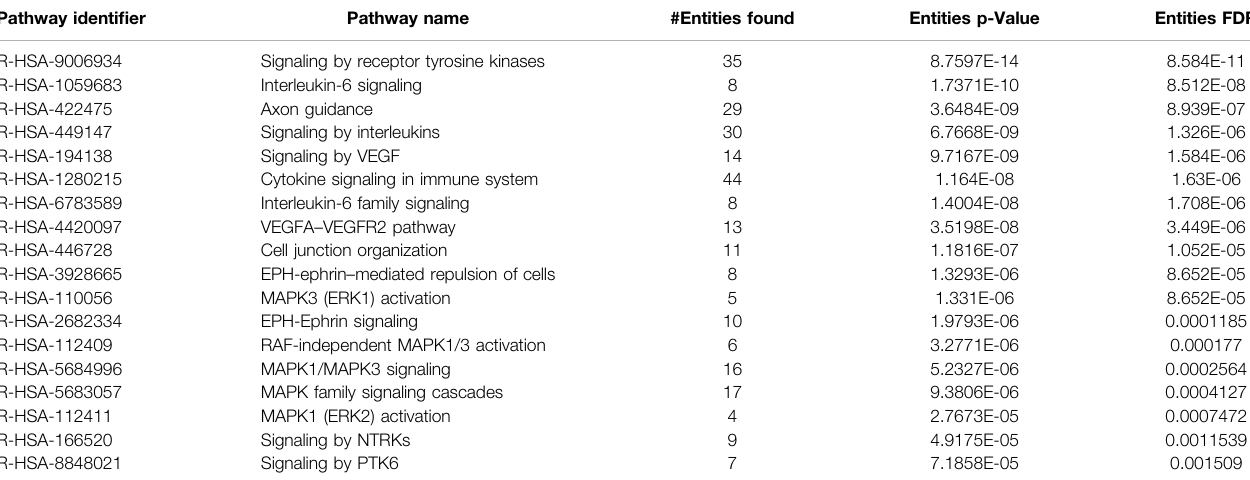
TABLE 3 | List of pathways signi fi cantly enriched from hypo-phosphorylated proteins upon inhibition of CAMKK2 in gastric cancer cells. Pathway identi fi